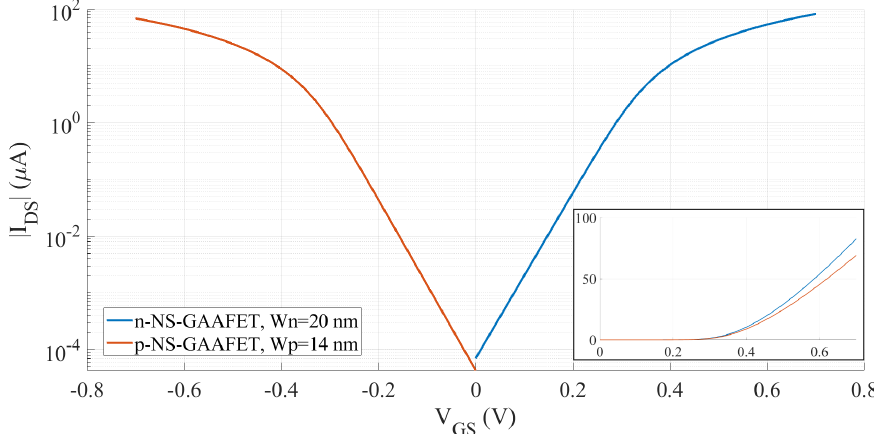
Figure 6. Optimized NS-GAAFET transcharacteristics I DS ( V GS ): n-type ( W n = 20 nm)—blue curves; p-type ( W p = 14 nm)—orange curves; the inset highlights the same curves in linear